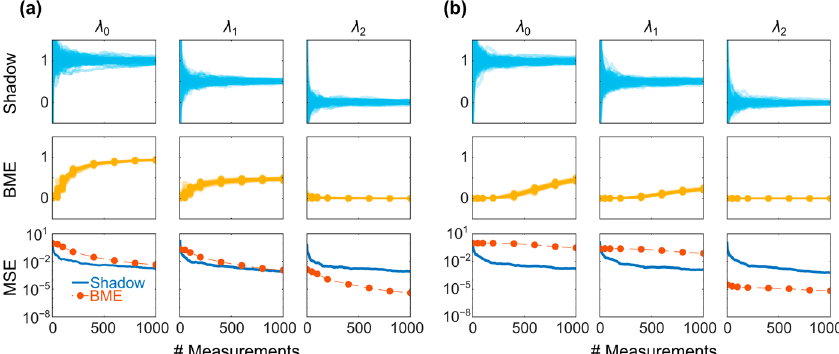
Fig. 1 Comparison of shadow and BME estimates of λ n (Picture 1). a D = 32 case. b D = 256 case. Results from 50 trials for each dimension are plotted, assuming a fi xed ground truth state 0 j i